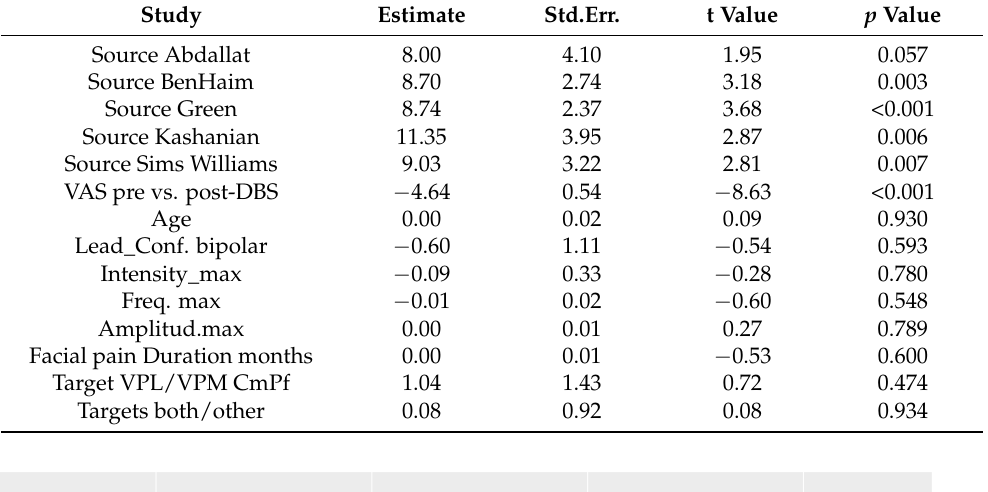
Table 2. IPD synthesis for changes in pain intensity quantified by VAS reduction. Table 2 shows the estimated baseline values of the studies and the estimated overall effect of − 4.64 points with a standard error of 0.54 points. Covariate assessment included age, contact configuration, intensity, frequency, amplitude, duration of pain disorder, and DBS target. The reference level for variable “Target” was PVG/PAG.